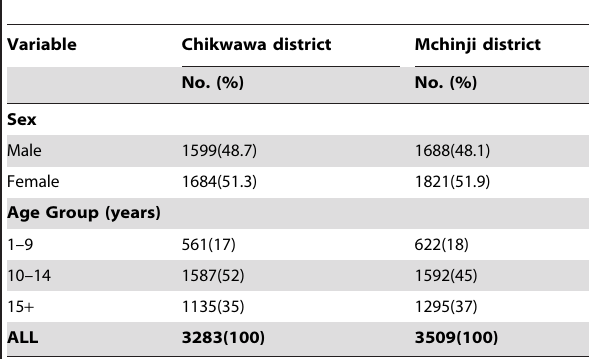
Table 1. Baseline characteristics of the study